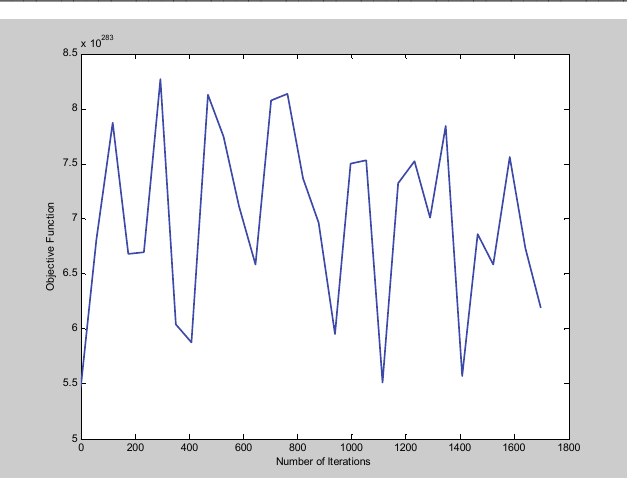
Fig. 15. Channel capacity of